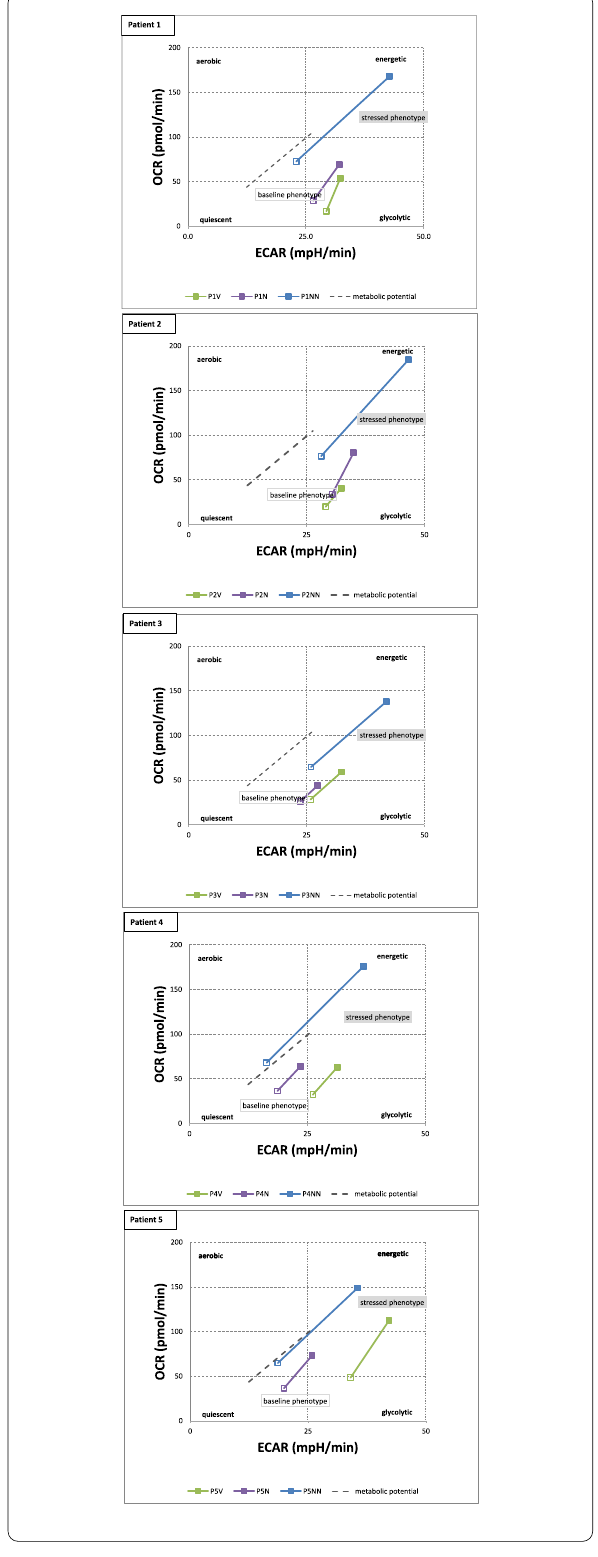
Fig. 5 Changes in the mitochondrial and glycolytic profiles (energy phenotype) due to OHT. Metabolic profile of the stimulatory effect of FCCP treatment on aerobic and anaerobic respiration: The OCR and ECAR were plotted against one another at the time where OCR was baseline (baseline phenotype) and where OCR increased to the greatest extent in cells treated with FCCP (stressed phenotype). P1-P5: patients 1 – 5; V: before OHT; N: after the first OHT; NN: after the 2. OHT (one week later). The data are expressed as